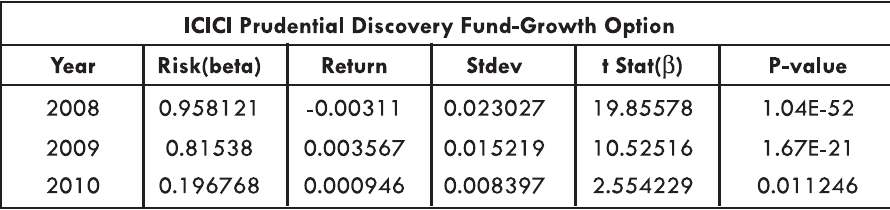
Table 9 :Risk and Returns of ICICI Prudential Discovery Fund-Growth Option Scheme during the Study Period (2008 to 2010)